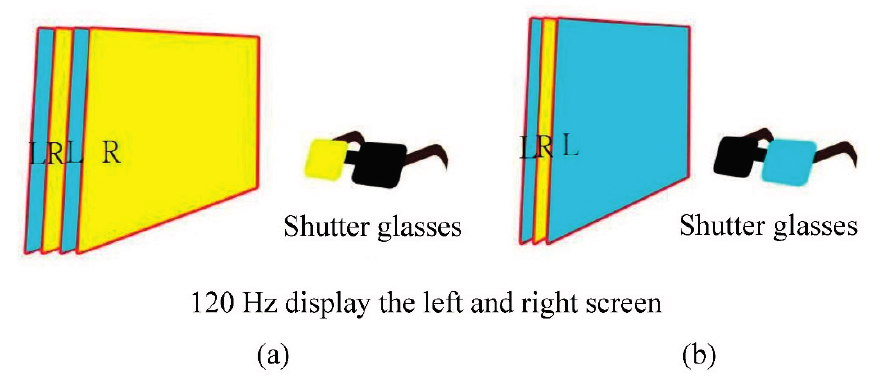
Figure 4. Active 3D glasses: ( a ) right and ( b ) left frame